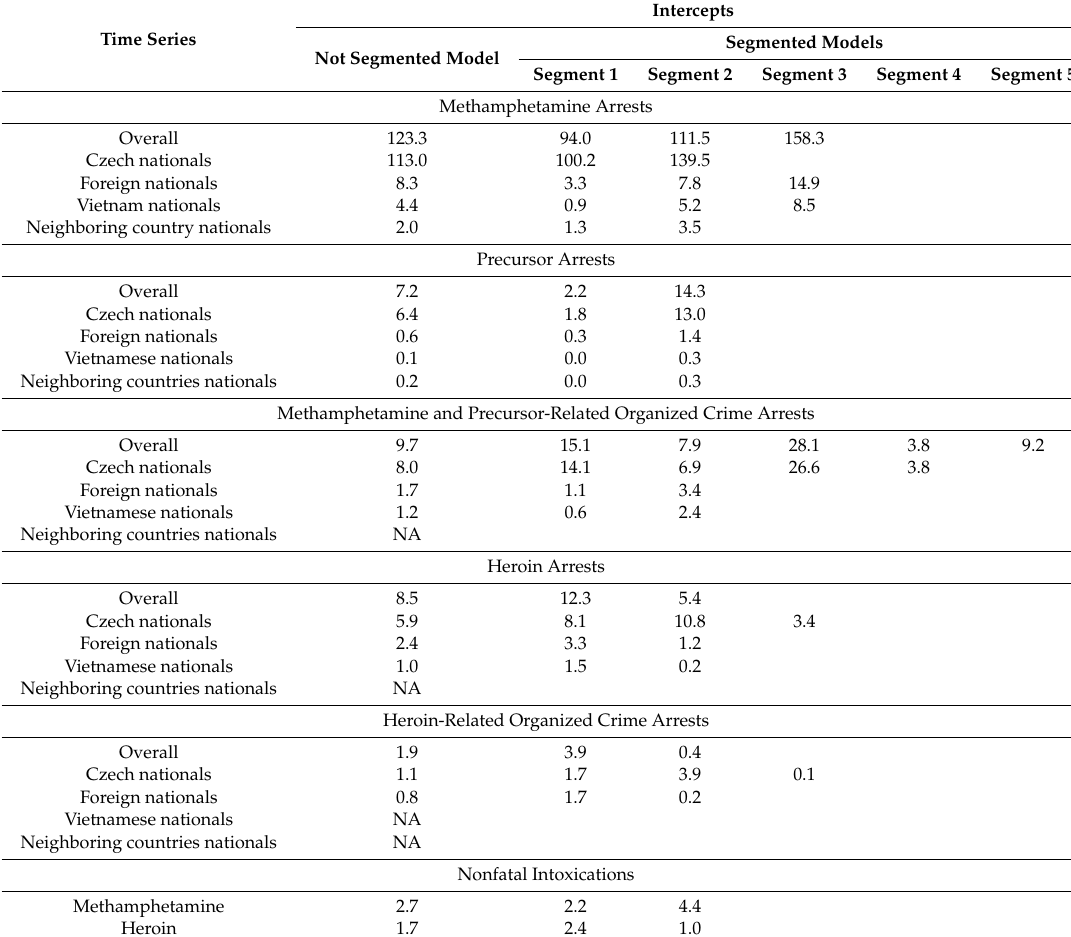
Table 2. The intercepts in the di ff erent models and di ff erent segments of